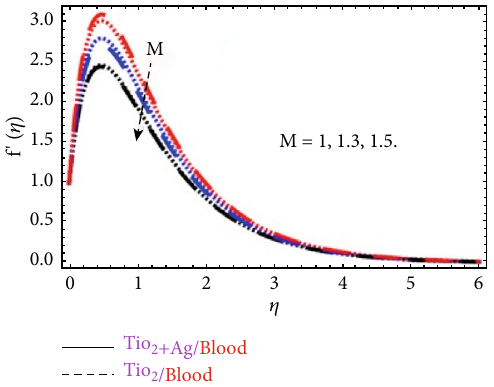
Figure 2: Inspiration of magnetic fi eld parameter M on velocity pro fi le.